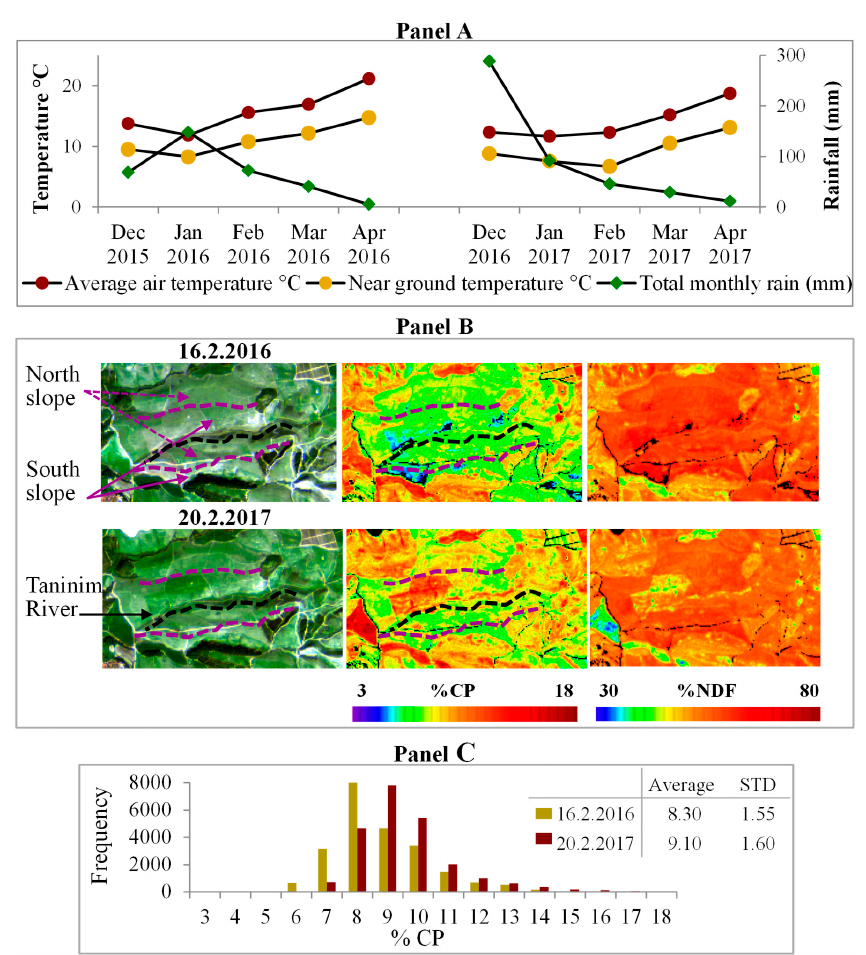
Figure 9. Comparisons between two winter seasons in 2016 and 2017 of: monthly rainfall and temperature (Panel A); estimated spatial CP and NDF maps using the reflectance model (Panel B); and frequency distributions of the per-pixel CP values (Panel C) in the maps shown in Panel B.